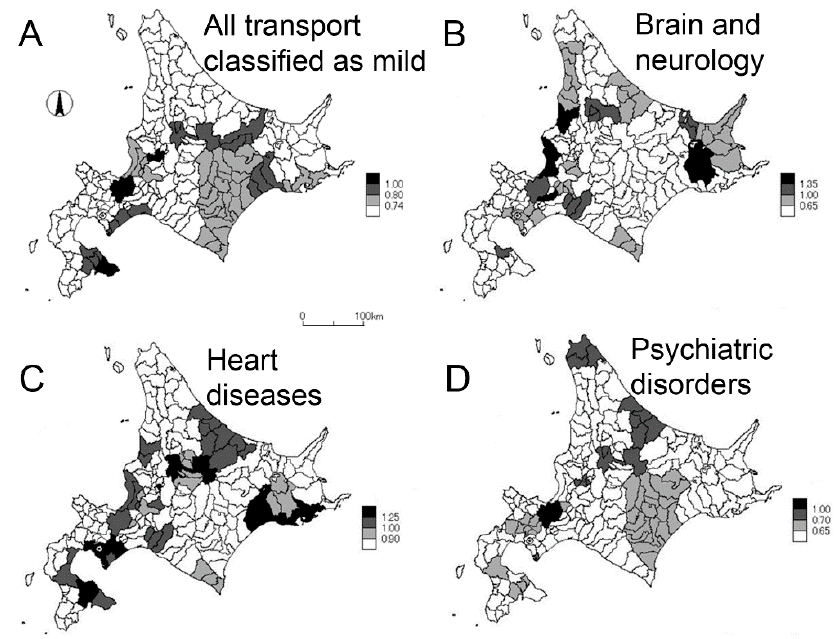
Figure 2. Geographic distributions of the standardized transport ratio for mild diseases, according to administrative district of emergency services. The standardized transport ratio for mild diseases upon arrival was calculated using Sapporo, the capital city, as the baseline, adjusting for the age distributions. Four discrete categories were defined and scaled (lower right of each panel). ( A ) All diseases, ( B ) brain and neurological disorders, ( C ) heart diseases, and ( D ) psychiatric disorders.